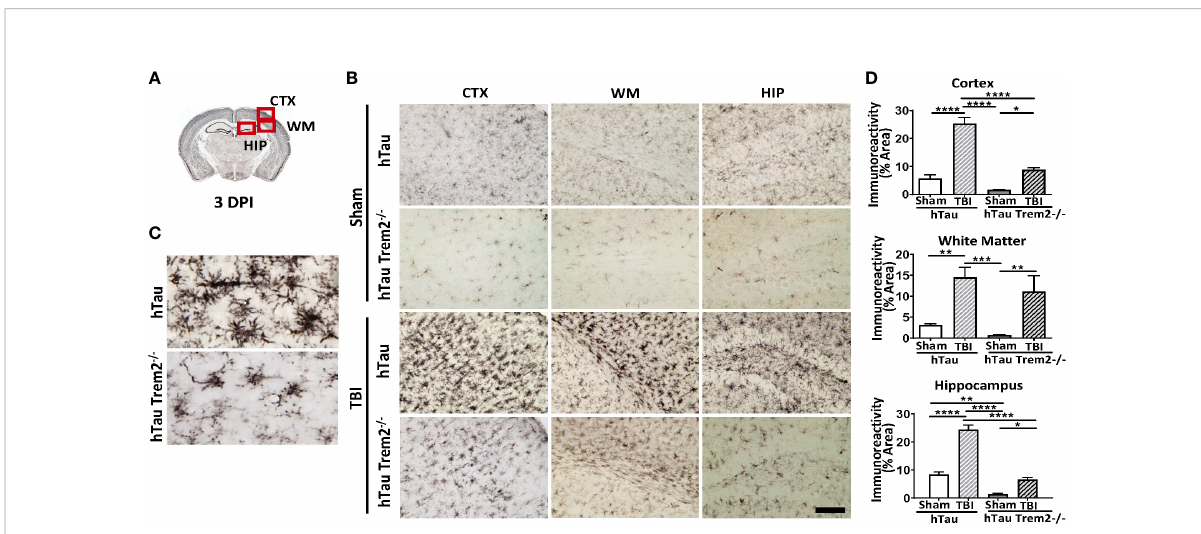
FIGURE 1 Traumatic brain injury (TBI) induces enhanced microglial/macrophage response in hTau mice and hTau; Trem2 -/- mice at 3 days post-injury (DPI). (A) The diagram shows areas where images were taken from. CTX, cortex; HIP, hippocampus; WM, white matter. (B) Representative images of F4/80 immunostaining in sham and TBI of hTau and hTau; Trem2 -/- mice in the lateral CTX, WM, and HIP at 3 DPI. (C) Magni fi ed view of F4/80 immunostaining in hTau TBI mice and hTau; Trem2 -/- TBI in the lateral CTX. (D) Quanti fi cation of percent area covered by F4/80. All experiments used n = 6 (equal males and females) mice per group unless otherwise noted. At least two independent experiments were performed for each analysis. The scale bar represents 50 m m. Error bars indicate SEM; * p <0.05, ** p <0.01, *** p <0.005, **** p